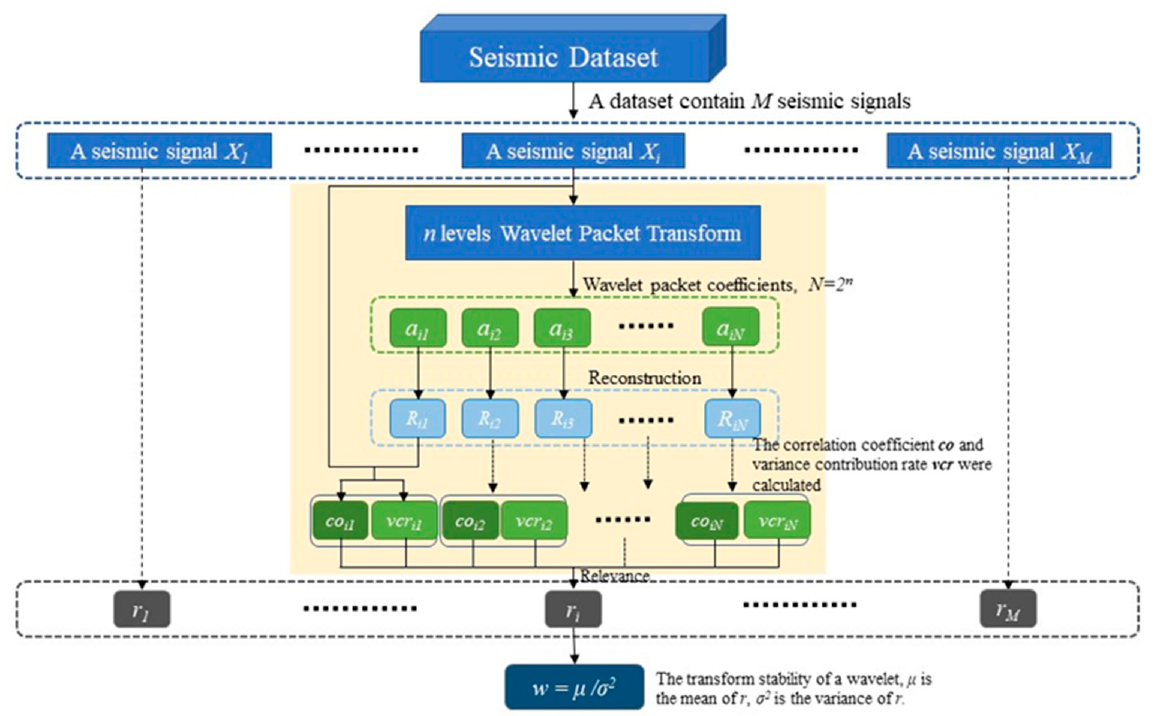
Figure 5. The calculation approach of the stability w of wavelet packet transform. For a wavelet, perform wavelet packet decomposition on each signal in the dataset, and then use each wavelet packet coefficient to reconstruct the signal. Correlation coefficients co and variance contribution rates vcr were calculated between the reconstructed and original signals. The co and vcr can calculate the relevance between a wavelet and a signal. Therefore, the stability obtained from the mean and variance calculations of the variance can be used for wavelet selection, and the wavelet with the highest stability is the most appropriate.